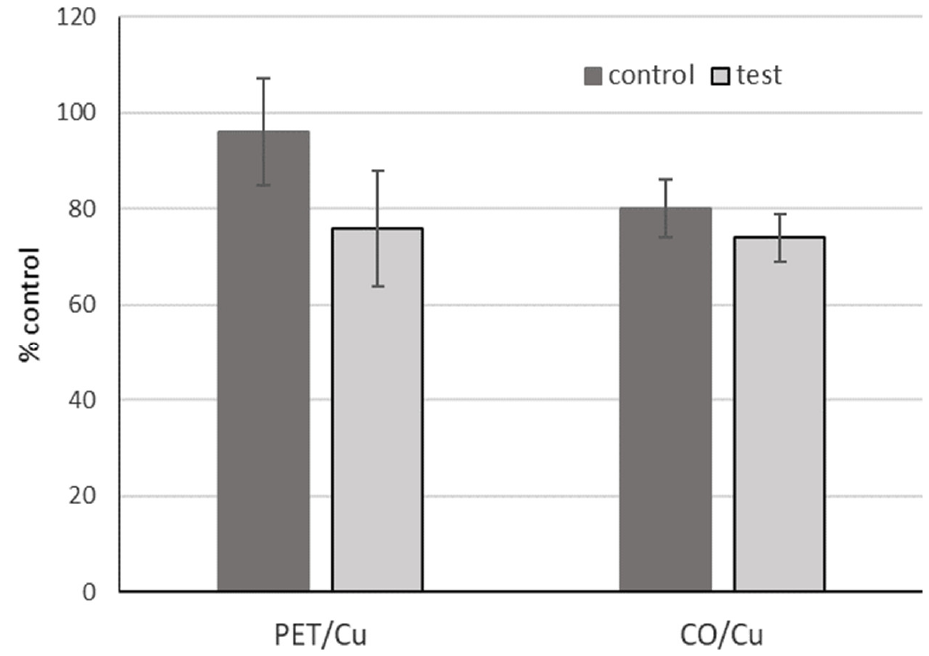
Figure 5. Toxicity of tested samples with MTT method (Cell viability versus control).